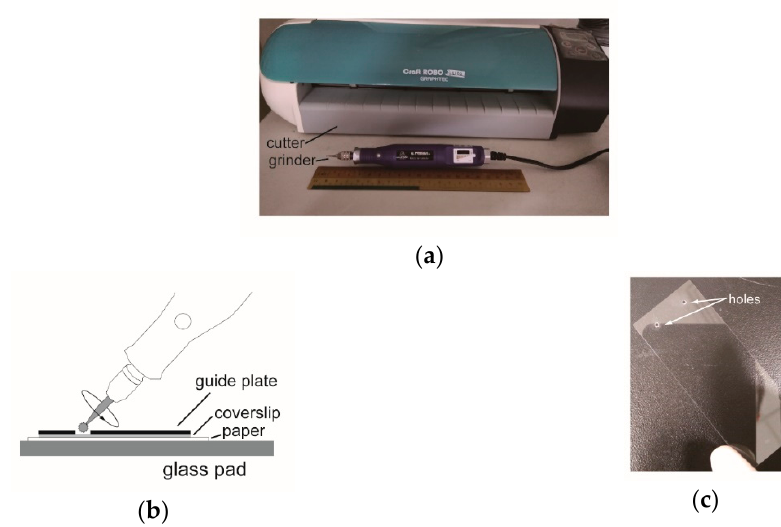
Figure 3. Tools used in making microfluidic chips. ( a ) A craft paper cutter and mini grinder. A 20-cm ruler is also displayed. ( b ) The use of a mini grinder to drill holes on a coverslip. ( c ) A coverslip